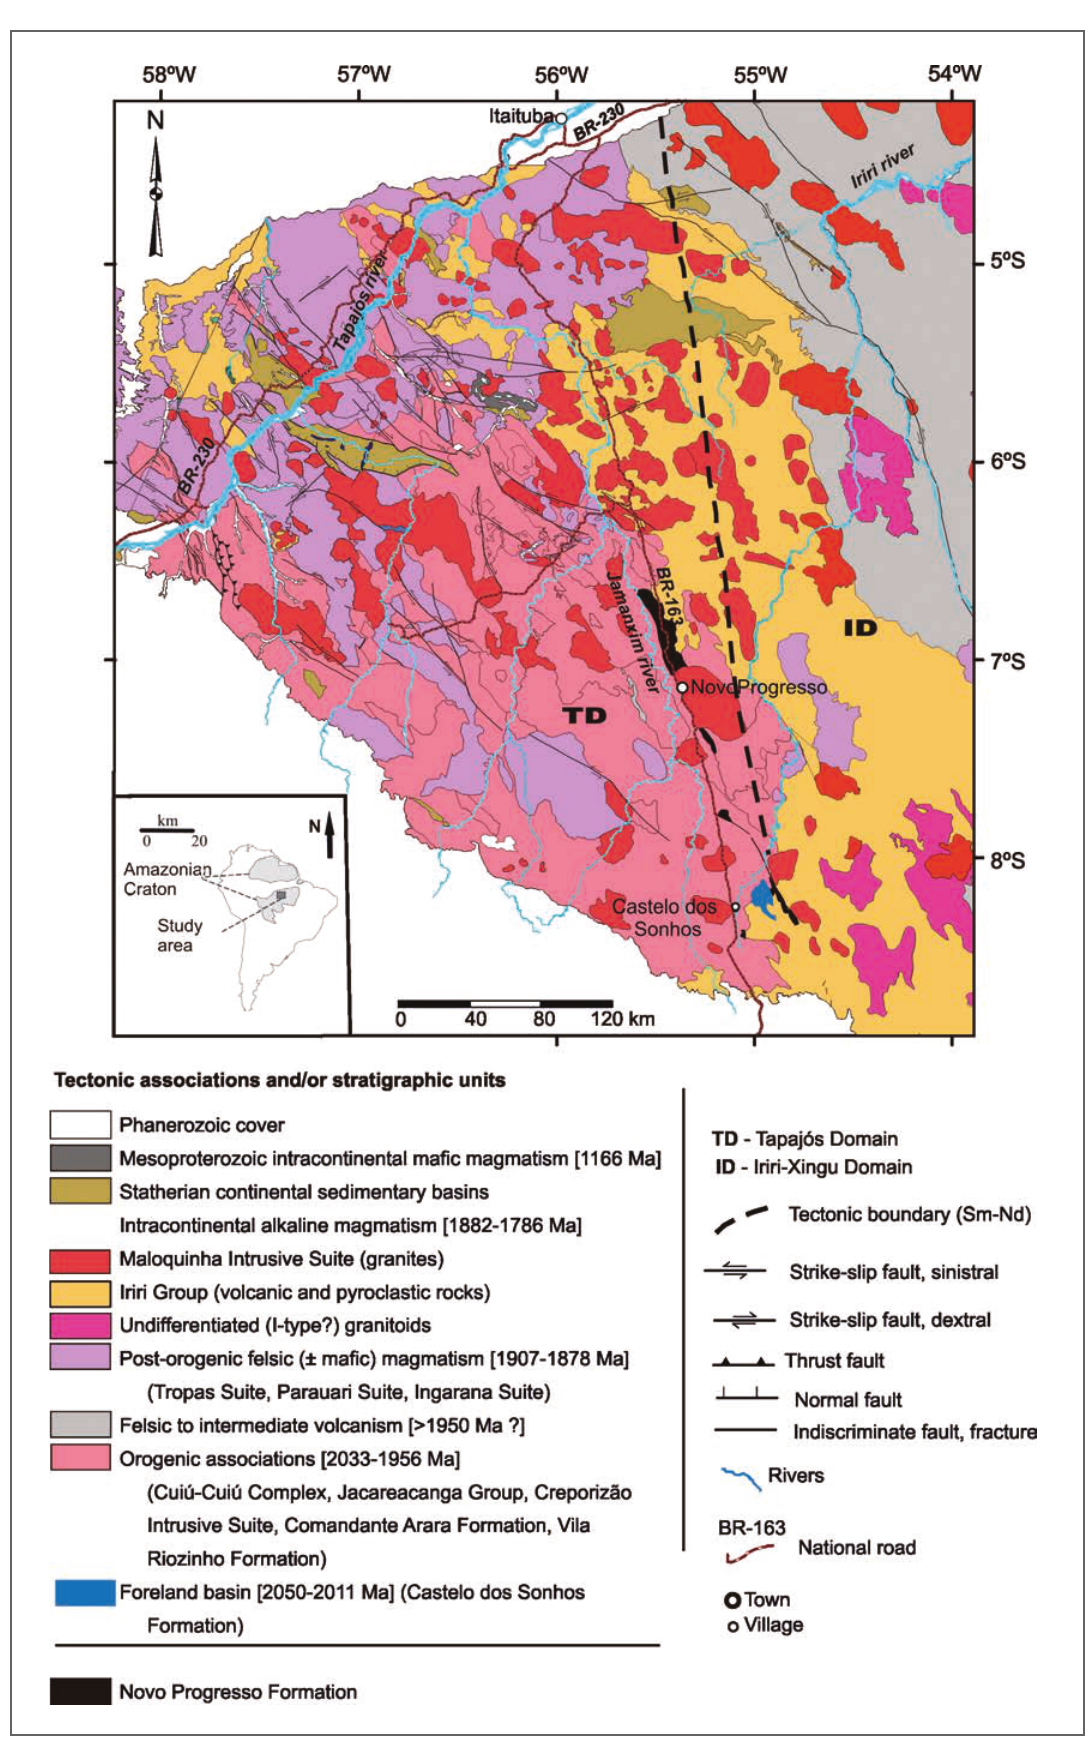
Figure 2 - Location (inset) and simplified map of tectonic associations of the Tapajós and Iriri-Xingu domains of the Amazonian Craton (modified from Vasquez et al.